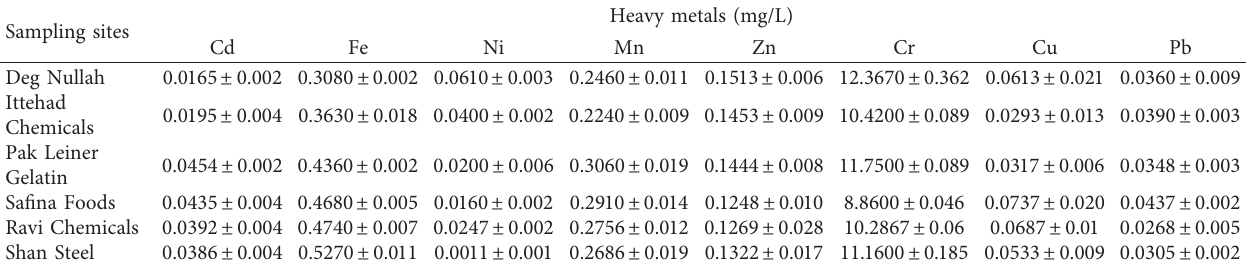
Table 2: Mean values and SD of heavy metal concentrations in wastewater at different sampling sites. Sampling sites